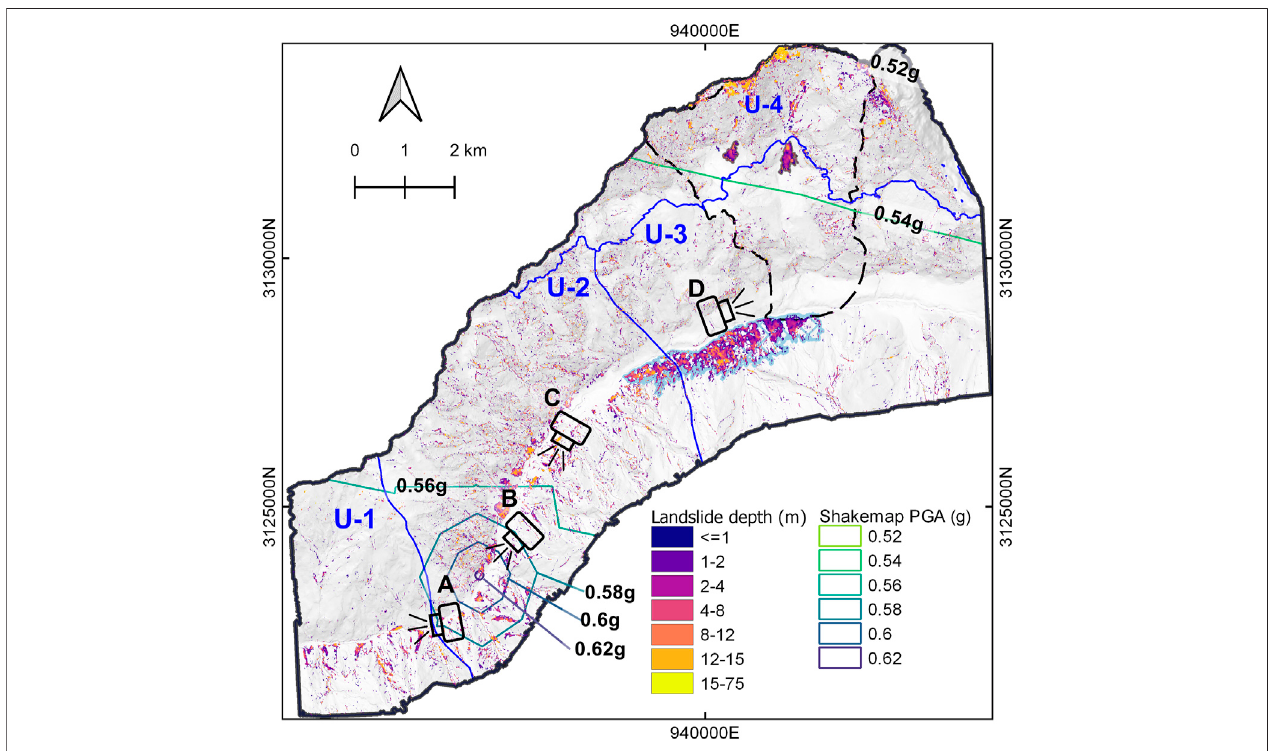
FIGURE 3 | Landslide source area cells computed from pre- and post-earthquake DEM differences and adjusted for DEM elevation accuracies, modi fi ed after Lacroix (2016). (A – D) are camera locations corresponding to Figure 2 . The difference between the 2 DEMs encompasses both the landslide depth and the removal of trees over the landslide. USGS Shakemap contours of the peak ground acceleration (PGA) ranging from 0.52 g (at U-4) to 0.62 g (at U-2) are shown in shades of green to